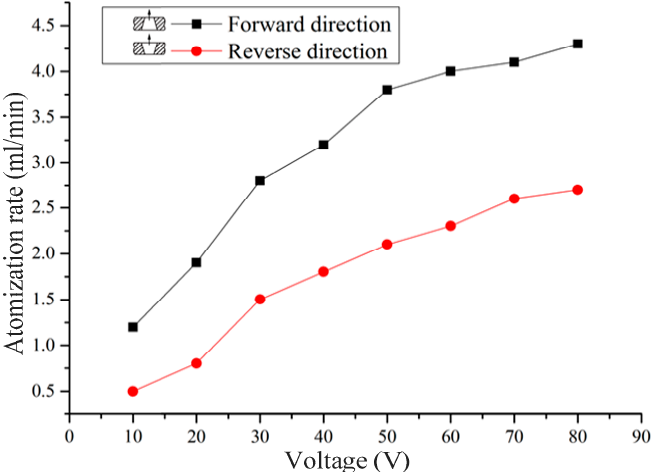
Figure 11. Variation in the atomization rates with working voltage.